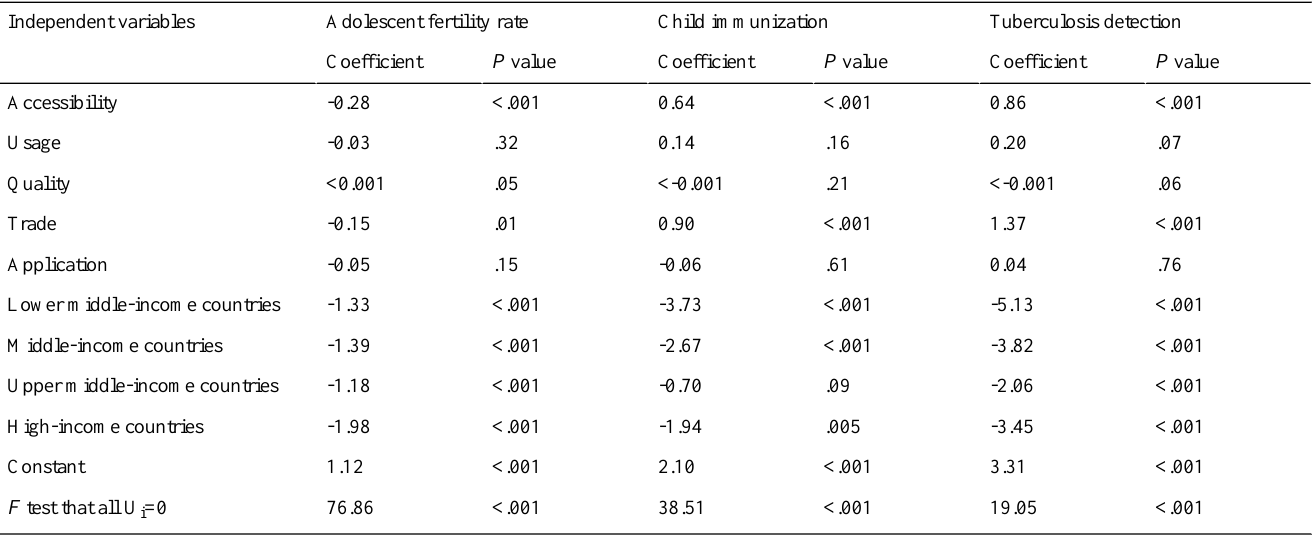
Table 3. Associations between ICT factors and public health delivery indicators (adolescent fertility rate, child immunization, and tuberculosis detection).